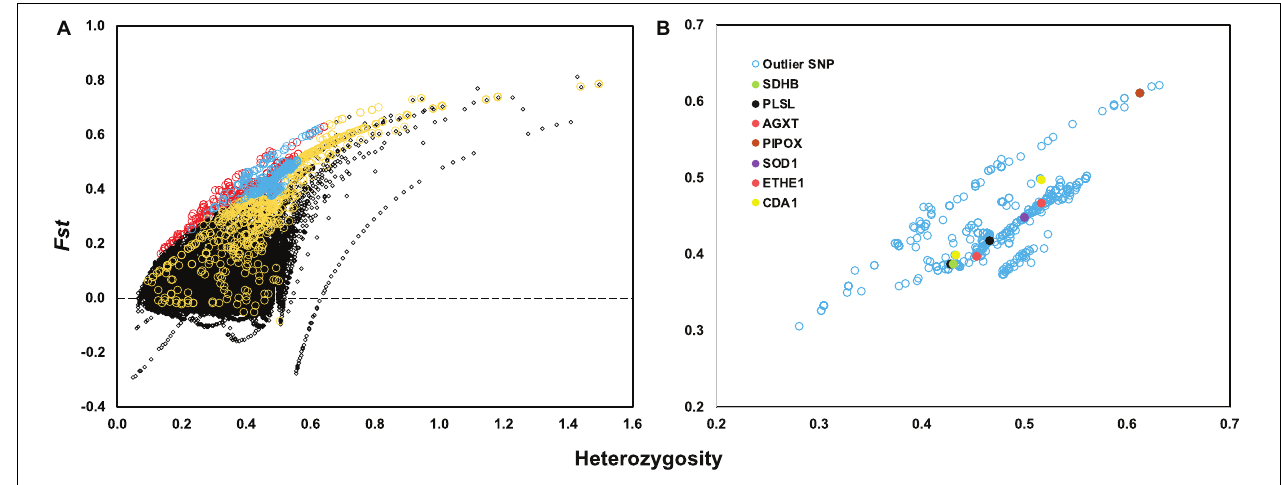
FIGURE 3 | (A) Locus-specific F st is plotted against observed heterozygosity (Heterozygosity) with black circles indicating neutral SNPs, red circles indicating outlier SNPs only identified by Arlequin, yellow circles indicating outlier SNPs only identified by PCAdapt and blue circles indicating overlapped outlier SNPs identified by two methods. (B) A total of 504 outlier SNPs is plotted based on observed heterozygosity and locus-specific F st value with seven genes highlighted with different colors.